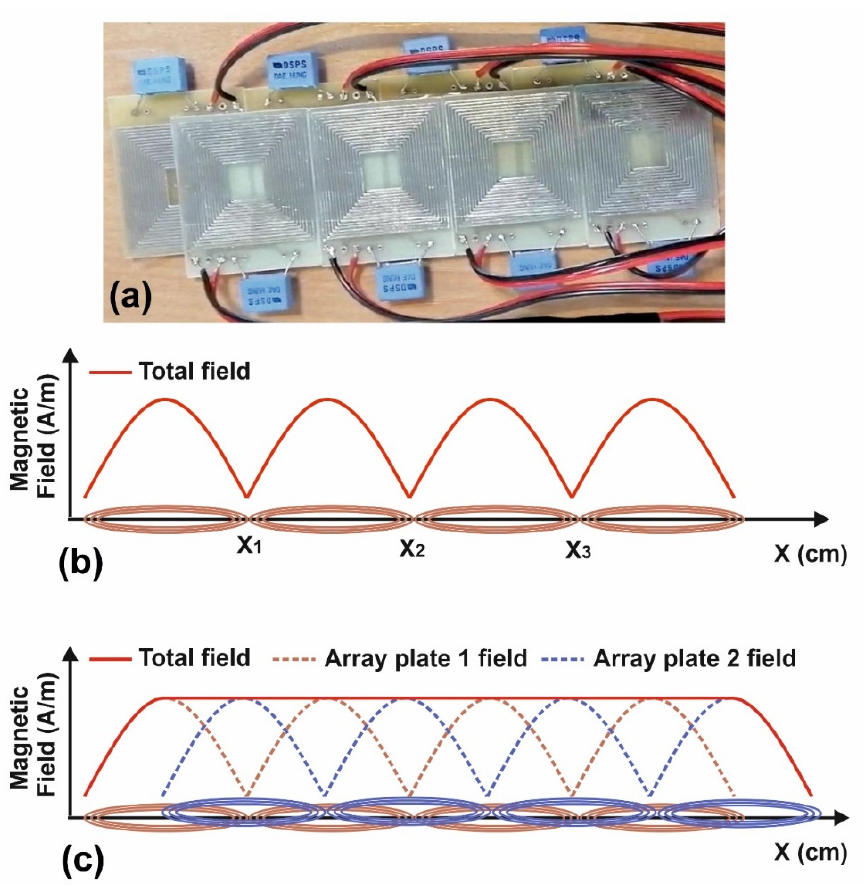
Figure 4. ( a ) Fabricated coil arrays. ( b ) Schematic of one plate array coil vs. electromagnetic field distribution. ( c ) Schematic of two overlapped plate array coils vs. electromagnetic field distribution.